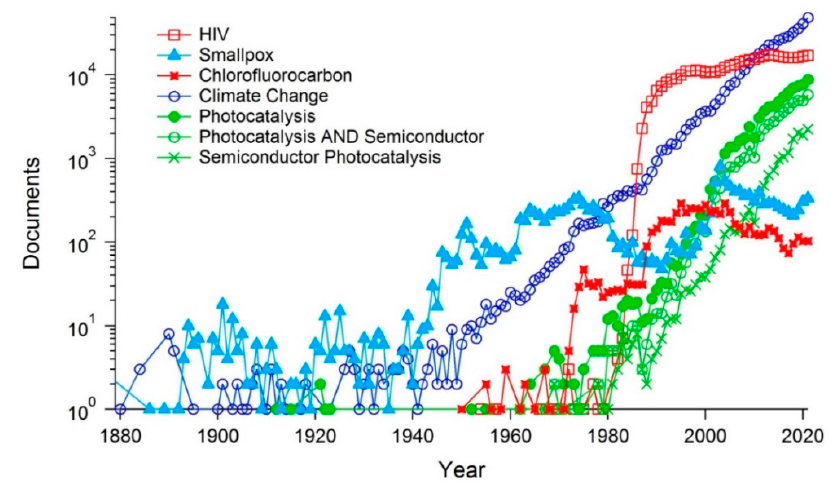
Figure 3. Number of published documents per year as functions of the publication year for several